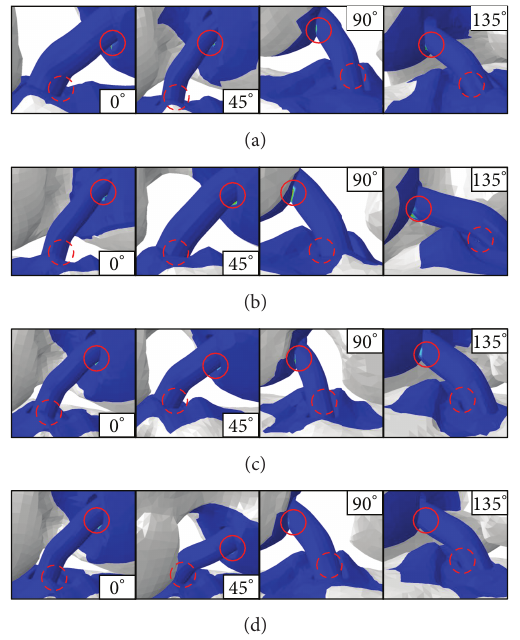
Figure 14: Contact regions and analysis results between bone and ACL: (a) Method 1, (b) Method 2, (c) Method 3, and (d) Method 4.